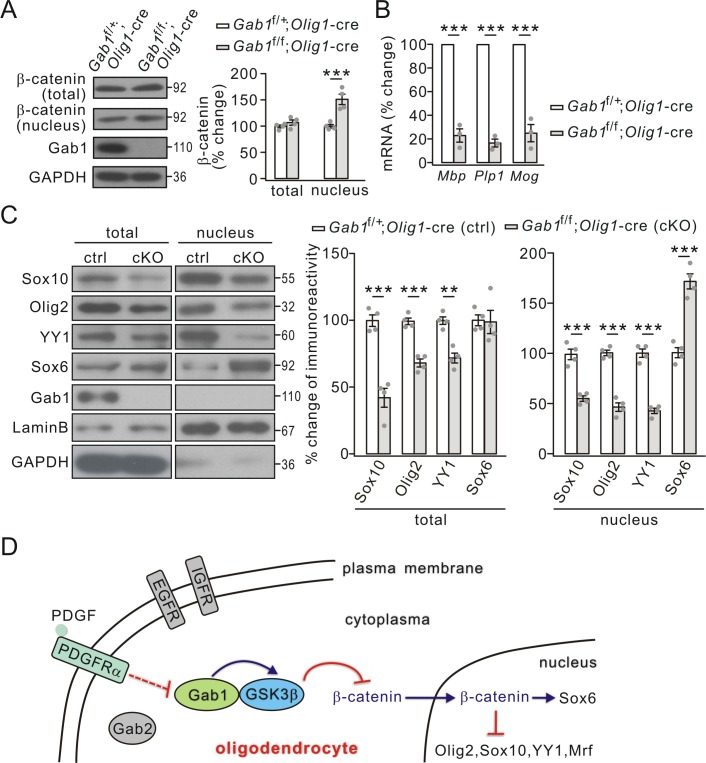
Effects of conditional Gab1 deletion on β-catenin and transcription factors.(A) β-catenin expression in total and nuclear fractions from Gab1f/+;Olig1-cre and Gab1f/f;Olig1-cre mice at P21. GAPDH was the internal control. Percentage changes were 108 ± 6% (total; p=0.25) and 151 ± 11% (nuclear; p=0.0027) in Gab1f/f;Olig1-cre mice. n = 4/group. t-test, df = t(7). (B) mRNA levels of myelin genes in Gab1f/+;Olig1-cre and Gab1f/f;Olig1-cre mice. Gapdh was the internal control. Percentage changes in Gab1f/f;Olig1-cre group were 23 ± 7% (Mbp; p=0.00015 vs control), 34 ± 4% (Plp1; p=0.000013 vs control) and 25 ± 9% (Mog; p=0.00054 vs control). n = 3/group. t-test, df = t(5). (C) Total and nuclear transcription factors in Gab1f/+;Olig1-cre (ctrl) and Gab1f/f;Olig1-cre (cKO) mice at P21. Lysates were immunoblotted with antibodies against Sox10, Olig2, YY1, Sox6, Gab1, LaminB, and GAPDH. All proteins were normalized to GAPDH (total) or LaminB (nucleus) and percent changes are shown. For total, percentage changes were: 42 ± 8% (Sox10; p=0.00044 vs control), 68 ± 4% (Olig2; p=0.0002 vs control), 72 ± 4% (YY1; p=0.0011 vs control), and 99 ± 10% (Sox6; p=0.9 vs control); p=vs control. For nucleus, percentage changes were 55 ± 3% (Sox10; p=0.00031 vs control), 47 ± 5% (Olig2; p=0.000041 vs control), 43 ± 3% (YY1; p=0.000025 vs control), and 172 ± 9% (Sox6; p=0.00023 vs control). n = 4/group. t-test, df = t(7). Gray dots indicate individual data points. (D) A working model illustrates the functions of Gab1 in OLs. Gab1 is specifically down-regulated by PDGF but not EGF or IGF. In WT condition, Gab1 binds to GSK3β and increases its activity, thereby inhibits nuclear accumulation of β-catenin and changes the expression of nuclear factors. As the result, Gab1 ablation leads to impaired OPC differentiation. Gray dots indicate individual data points. **p<0.01. ***p<0.001.